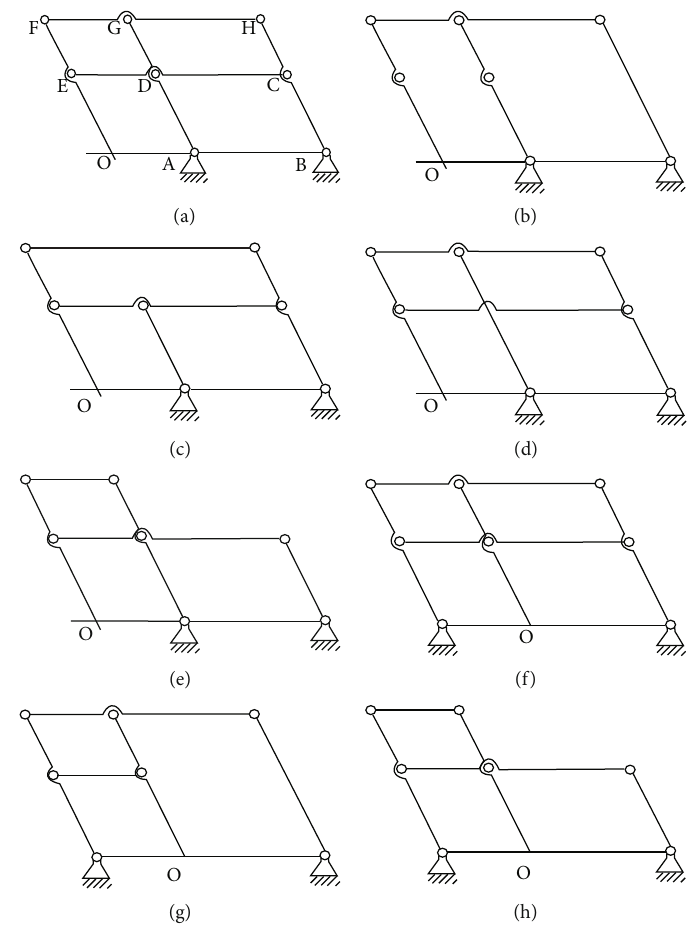
Figure 8: Expansion of multi-VRC modular units.